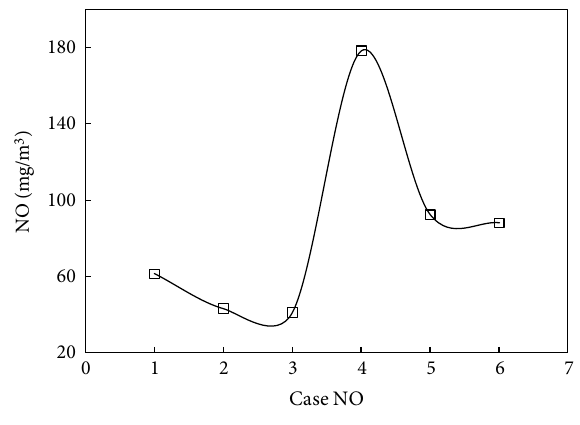
Figure 8: NO emission